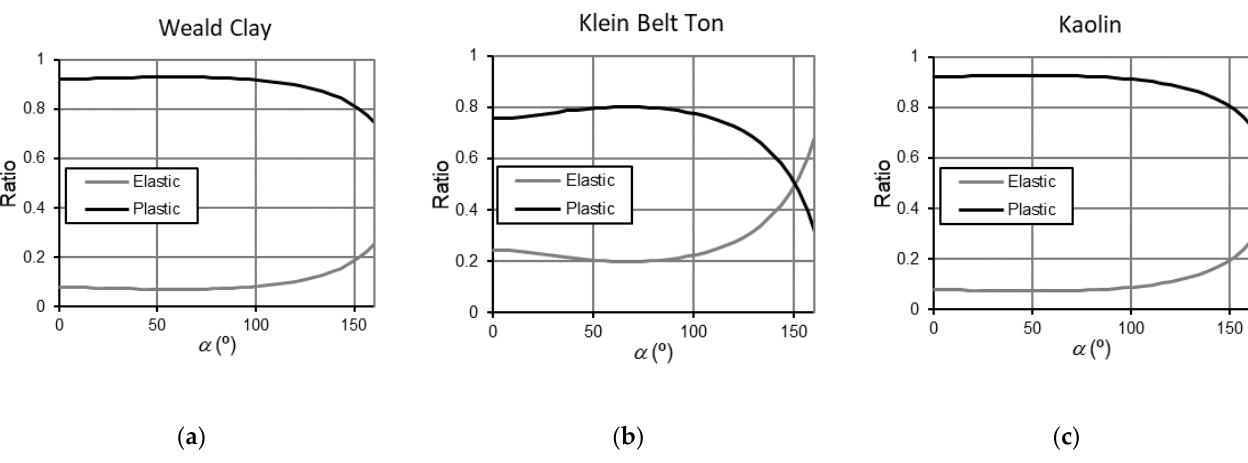
Figure 5. Minimum number N of subdivisions of the yield surface necessary to ensure a certain level of relative tolerance for each of the α strain paths defined in Figure 4 for ( a ) Weald clay, ( b ) Klein Belt Ton, and ( c ) kaolin.